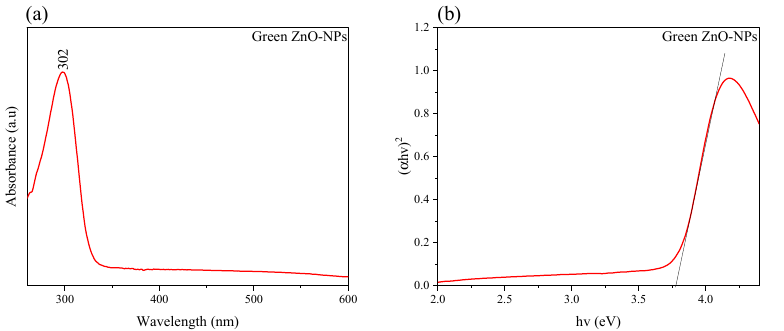
Figure 5. UV-visible absorption spectra ( a ), and Tauc plot ( b ) of biosynthesized ZnO-NPs using C. chinense fruits extract.